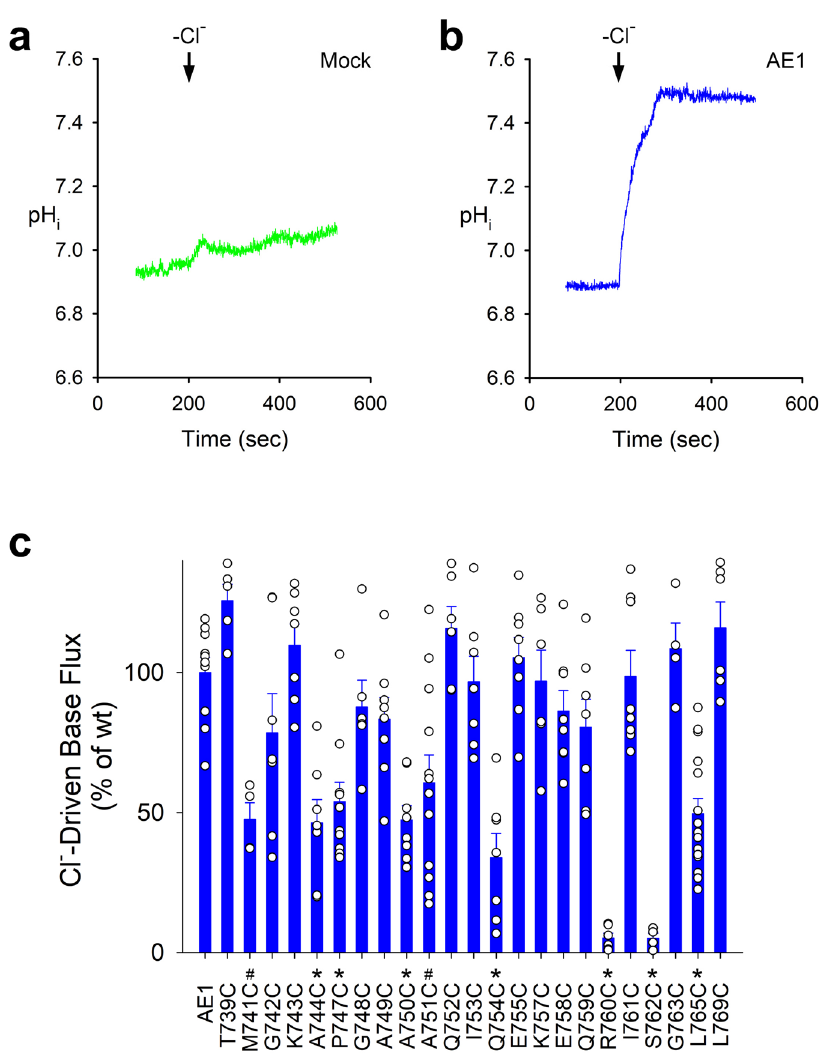
Fig. 5 Cl ‾ -driven base transport. Typical functional traces of mock a and wt-AE1 b transfected HEK293 cells. c AE1 wt ( n = 10 biologically independent experiments) and single cysteine functional mutant data (depicted as percent of wt-AE1): T739C ( n = 5, p = 0.4130); M741C ( n = 4, p = 0.0031); G742C ( n = 7, p = 0.5074); K743C ( n = 7, p = 0.9817); A744C ( n = 7, p < 0.0001); P747C ( n = 10, p = 0.0003); G748C ( n = 6, p = 0.9531); A749C ( n = 8, p = 0.7563); A750C ( n = 8, p < 0.0001); A751C ( n = 12, p = 0.0019); Q752C ( n = 6, p = 0.8550); I753C ( n = 7, p = 1.0000); Q754C ( n = 7, p <